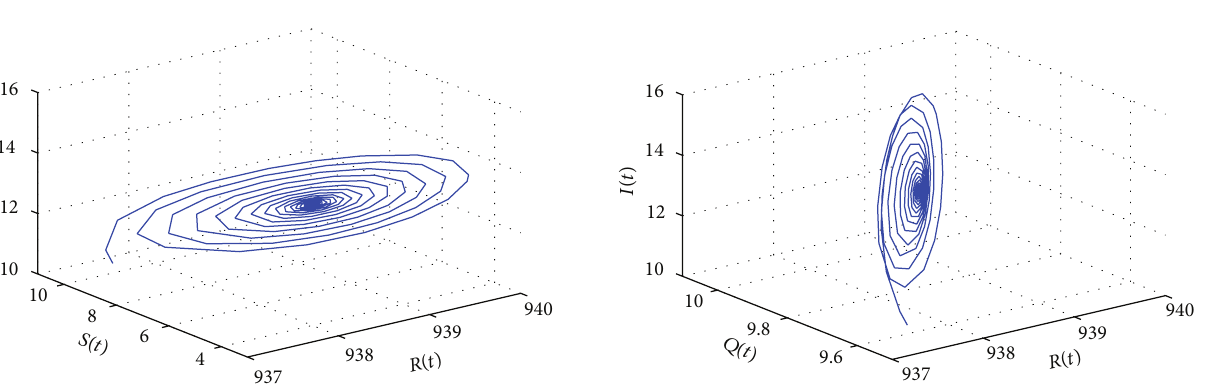
Figure 3: The phase plot of the states 𝐼 , 𝑄 , and 𝑅 for 𝜏 = 1.3025 < 1.3265 = 𝜏 0